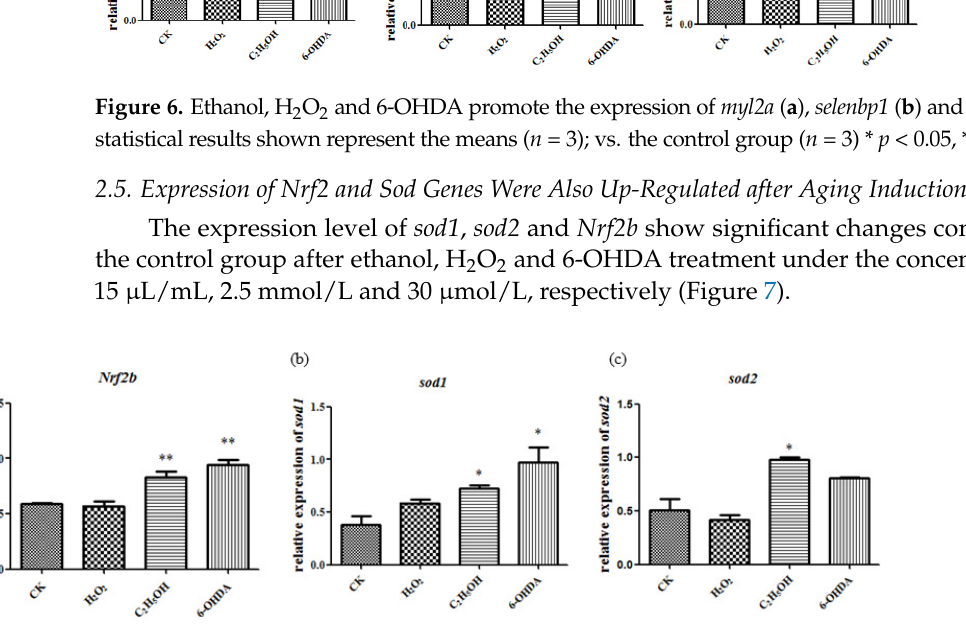
Figure 7. Ethanol, H 2 O 2 and 6-OHDA promote the expression of Nrf2b ( a ), sod1 ( b ) and sod2 ( c ). The statistical results shown represent the means ( n = 3); vs. the control group * p < 0.05, ** p <